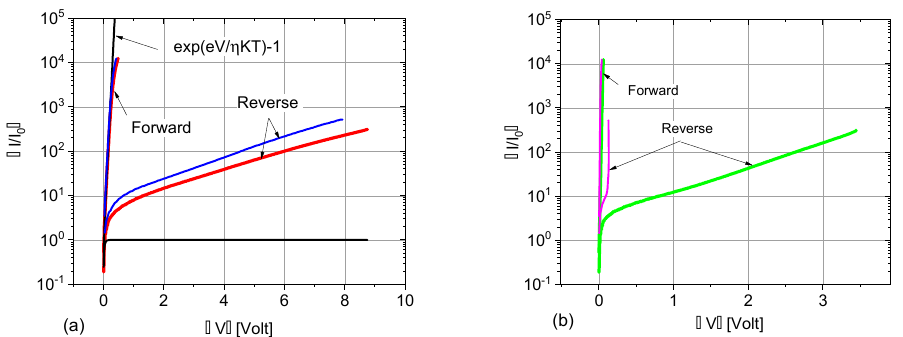
Figure 4. The I–V curves of p-type sample: ( a ) two-probe; ( b ) four-probe measurements. The red color corresponds to the nanograting area recorded using two probes; the blue color refers to the I–V recorded from the plain area using two probes; the green color refers to the nanograting area recorded using four probes, and the violet refers to the plain area recorded using four probes. Colors correspond to voltage and current terminals shown in Figure 2. Shockley equation fitting curve (for η = 1.25) is shown in black.